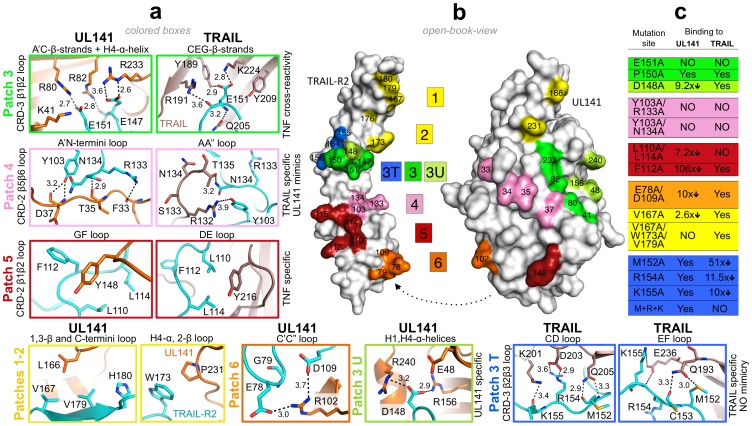
Comparison of receptor-ligand interaction between UL141 and TRAIL with TRAIL-R2 and mutational binding data.(a) Detailed interaction is shown for the six binding patches of the UL141–TRAIL-R2 complex; 1–2 (yellow), 3 (green), 3 U (light-green), 4 (pink), 5 (red), 6 (orange), as well as for the patches 3, 3T (blue), 4 and 5 of the TRAIL–TRAIL-R2 complex (same coloring scheme). Interaction residues are labeled and drawn as orange (UL141), salmon (TRAIL) and cyan (TRAIL-R2) sticks with atoms colored as follows: nitrogen (blue), oxygen (red) and sulfur (yellow). The molecular contacts (hydrogen bonds and salt bridges with distance <4.0 Å) are shown as dashed black lines. The name of interacting loop, helix or strand is listed around each box as well as the specificity of particular contact patch. (b) Open book view of UL141–TRAIL-R2 complex with their molecular surfaces outlined in grey. All binding patches (fingerprints on both molecules) follow the same color-code as above including residues selected for alanine scanning mutagenesis. (c) Relative effect on alanine mutagenesis of TRAIL-R2 on UL141 (middle column) and TRAIL (right column) binding, as analyzed by SPR (Figure 5 and Table S1). Mutated residues are listed (left column). Mutation that do not affect receptor binding are labeled ‘YES’ while ‘NO’ indicates binding is abrogated. X-fold reduction in binding (compared to wild-type) is quantitated by numbered arrows.